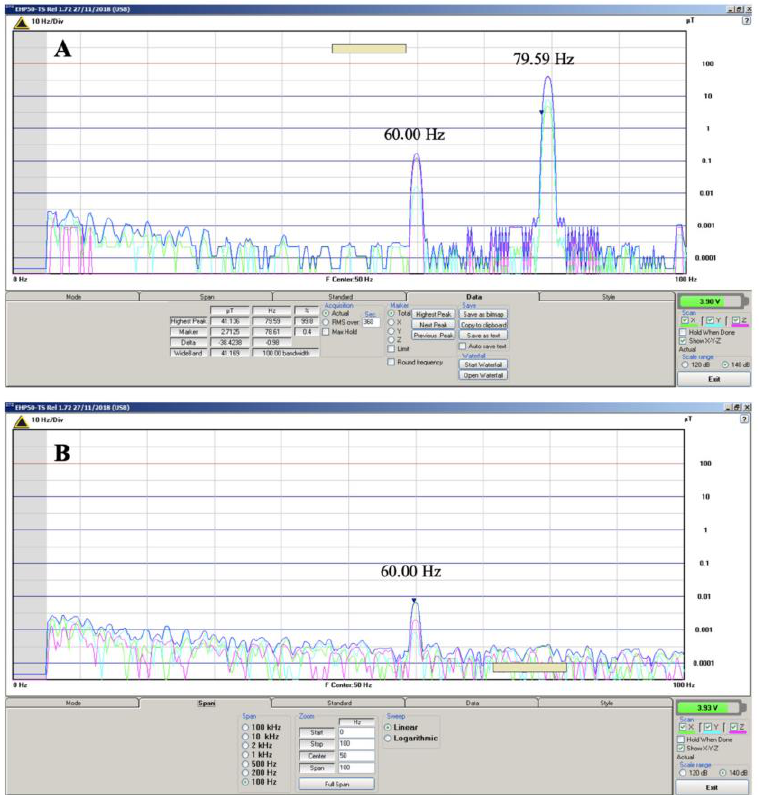
Figure 4. Intensity of the magnetic field generated by the small electrostimulator, ( A ) presence of the fields generated by the device and the scattered electric grid and ( B ) the field effect of the scattered electric grid.